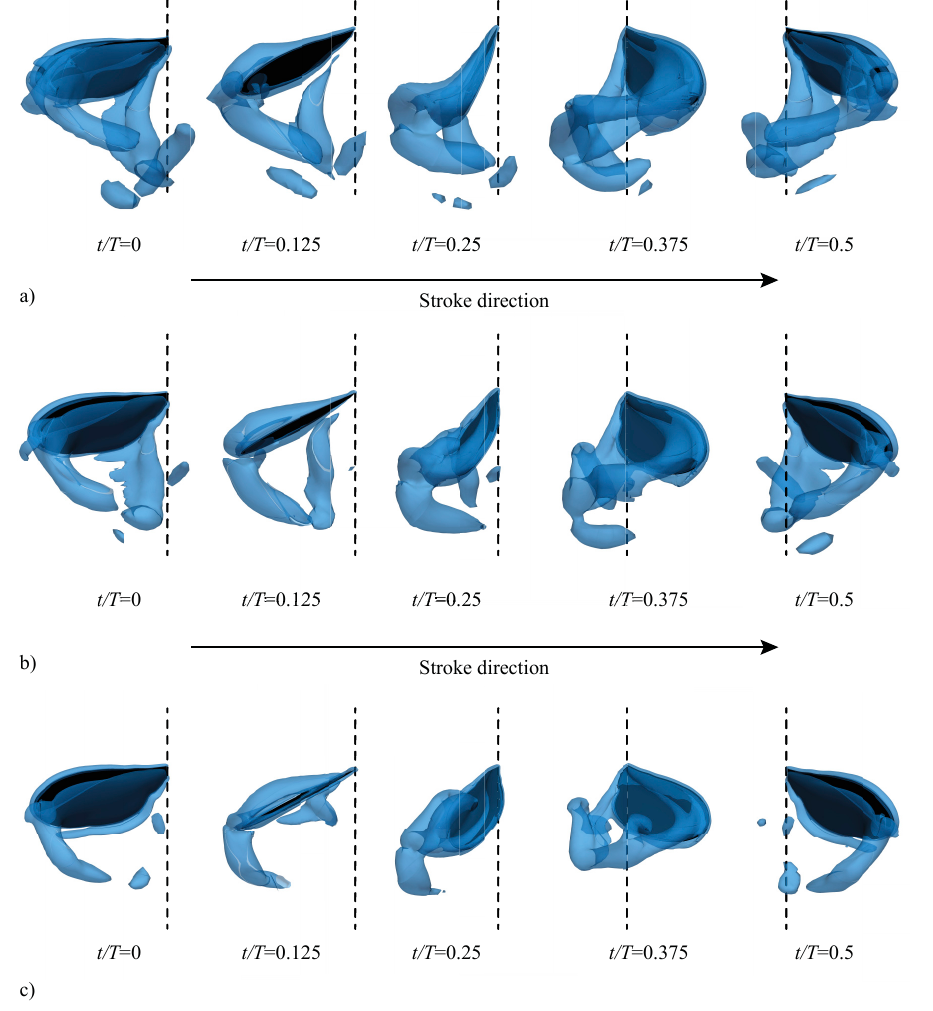
Figure 6. Contour plots of the NSe iso-surfaces of Q -criterion at Q = 0.75 for motions with Δ τ r = 0.3, x pa = 0.5 and ( a ) A = 30°, ( b ) A = 45°, and ( c ) A = 60°.